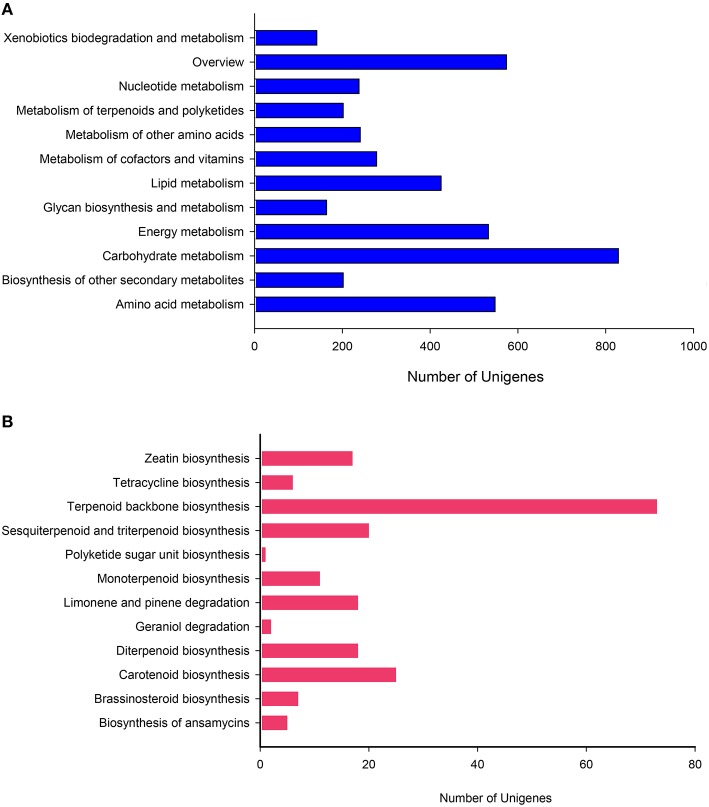
KEGG pathway mapping for D. asperoides. Classification based on (A) metabolism branch and (B) metabolism of terpenoids and polyketides.